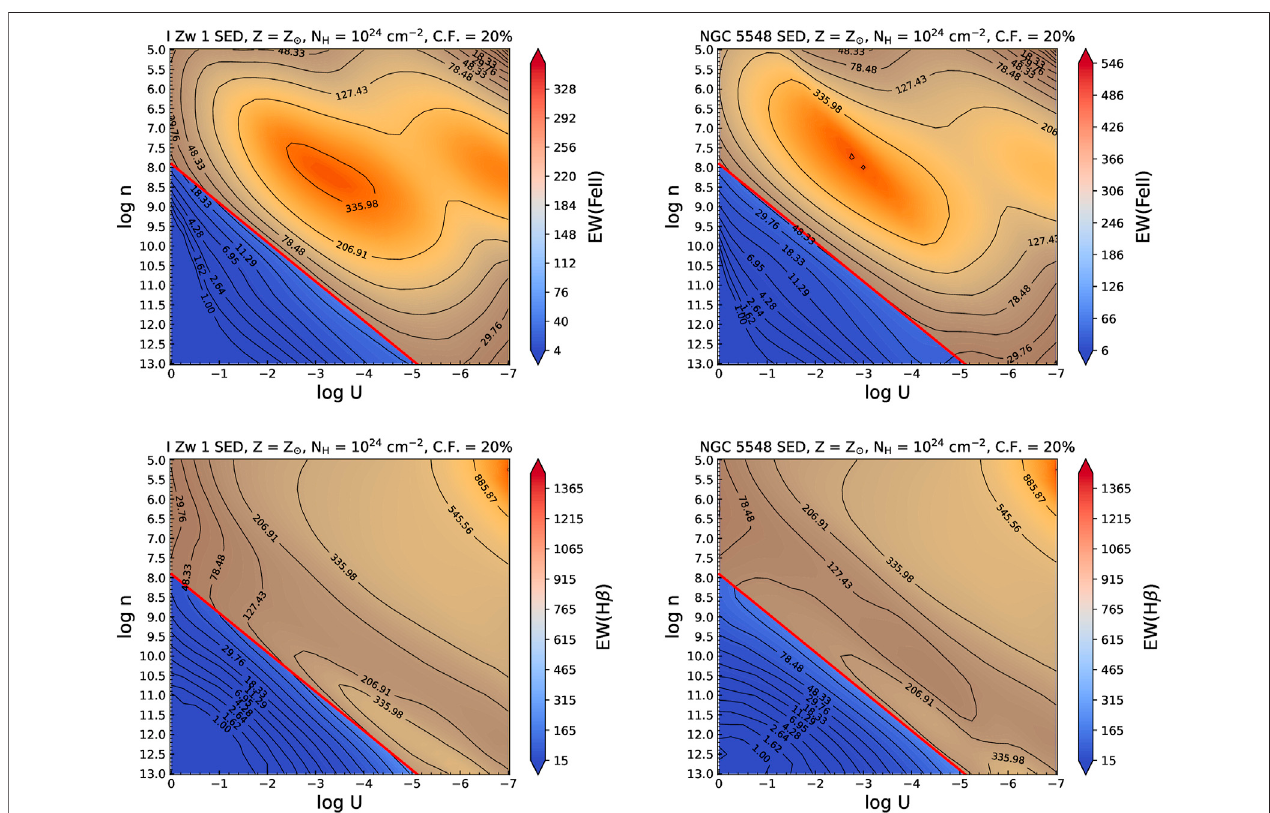
FIGURE 2 | log U − log n H 2D histograms color-weighted by (top panels) equivalent widths (EWs) Fe II and (bottom panels) EW(H β ). The EWs are computed assuming the continuum luminosity at 5,100 Å and at 20% covering fraction. Two different spectral energy distributions (SEDs), as previously shown in Figure 1 , are used representing (left panels) I Zw 1 — a prototypical Population A object with high R FeII and (right panels) NGC 5548 — a prototypical Population B object with relatively low R FeII . Models are shown for a characteristic BLR cloud with solar composition (Z = Z ⊙ ) and column density, N H = 10 24 cm − 2 . The solid red lines in each panel marktheboundarybetweenthenon-dusty(inblue)andthedusty(inorange).ThisissetuniquelyforeachcaseofSEDusingtheluminosity-dependent k bol (Netzer,2019) values for L bol and R sub as shown in Table 2 .